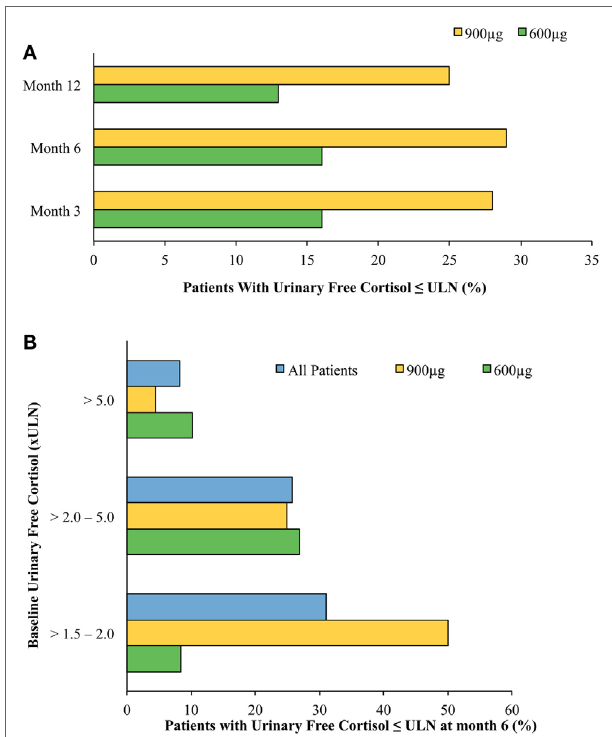
FiGURe 2 | Normalized mean urine free cortisol (mUFC) in patients treated with short-acting pasireotide (600 or 900 µg twice daily) (28). (A) Cushing’s disease (CD) remission by treatment arm by month. Patients treated with twice-daily subcutaneous pasireotide obtained normalization of mUFC at months 3, 6, and 12. Patients’ dosages were up-titrated beginning at month 3. Patients who were on higher pasireotide doses regardless of treatment arm showed better response. Patients who had greater than five times the upper limit of normal (ULN) mUFC were more likely randomized to the 600 µg twice-daily treatment arm, possibly accounting for discrepancies between treatment arms’ responsiveness to pasireotide. Patients with uncontrolled hypercortisolism were more likely to stop the study. (B) CD remission at month 6 stratified by baseline urinary free cortisol (UFC). Stratification of patients by baseline mUFC predicted response to treatment with twice-daily subcutaneous pasireotide. The lower the patient’s baseline mUFC, the more likely they were to obtain normalized free UFC levels. As above, patients who had greater than five times the ULN mUFC were more likely randomized to the 600 µg twice-daily treatment